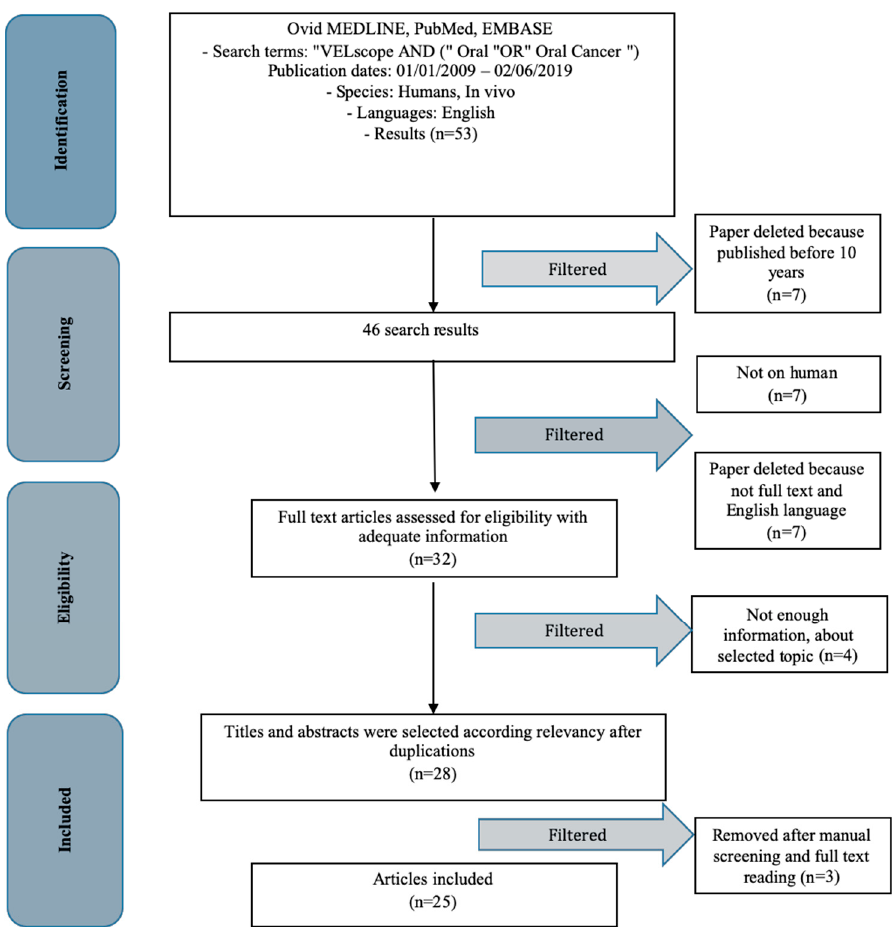
Figure 3. PRISMA flow chart.